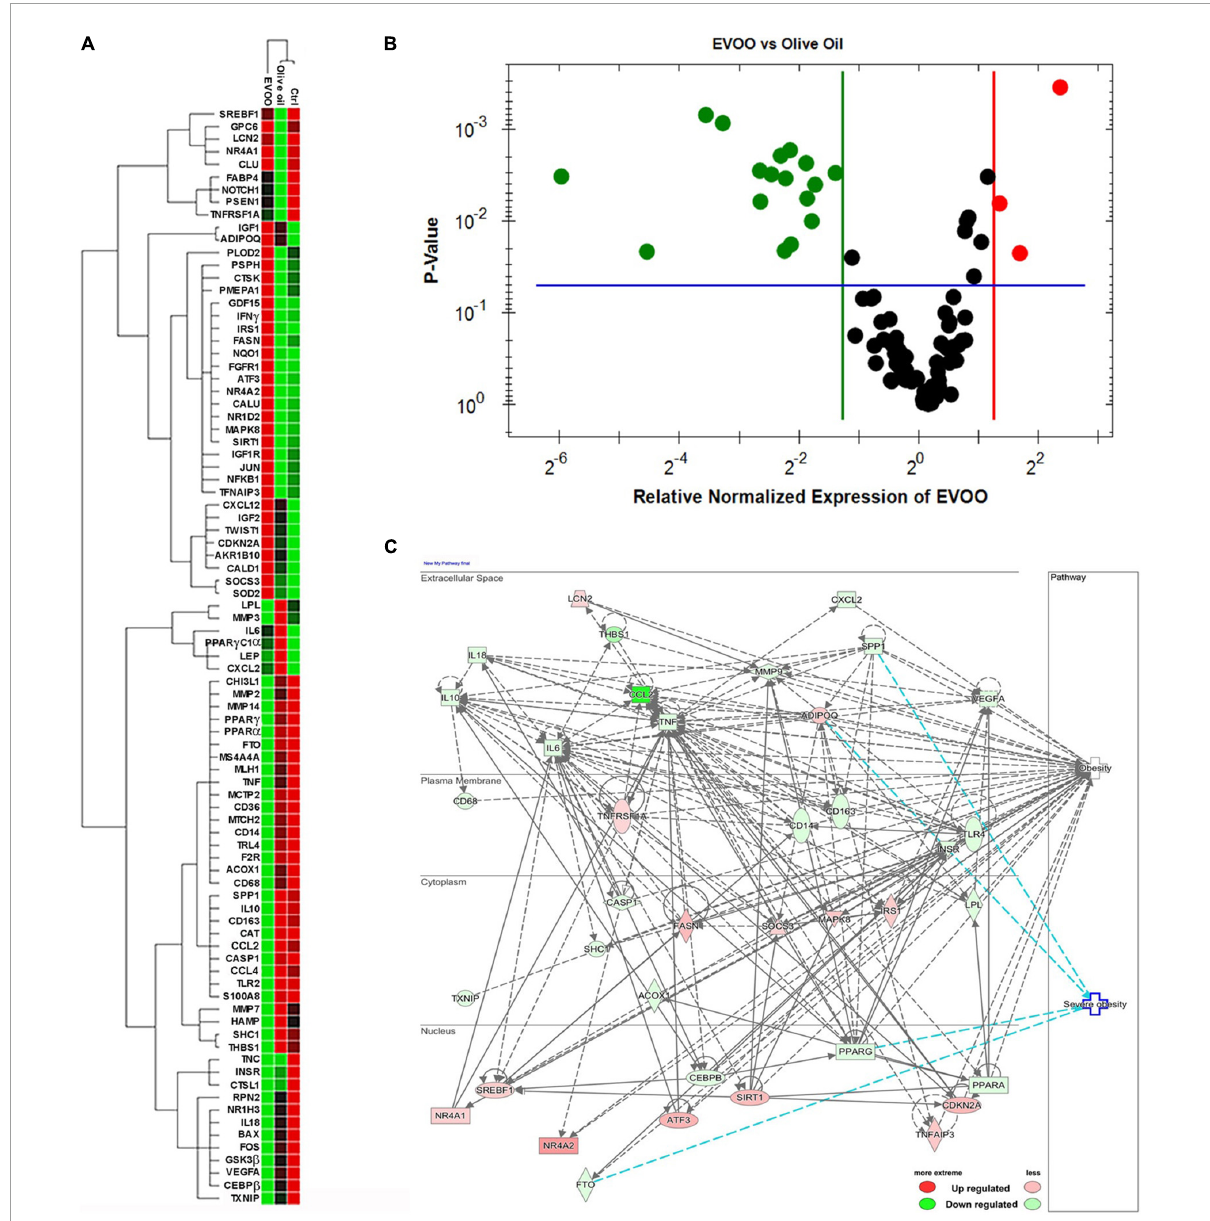
FIGURE2 The molecular profile of PBMCs from obese children is greatly modulated after the treatment with EVOO extract in terms of metabolic and inflammatory pathways. (A) Hierarchical clustering using the differentially expressed genes from PBMCs separately treated with EVOO, olive oil, and Ctrl for 6 h (6.25 µ g/mL; n = 9). (B) Volcano plot representation of differential expression analysis of genes in EVOO vs. olive oil treated PBMCs ( p < 0.05 and fold change threshold ≥ 2.4). (C) Networks analysis of obesity and severe obesity pathways generated by IPA for